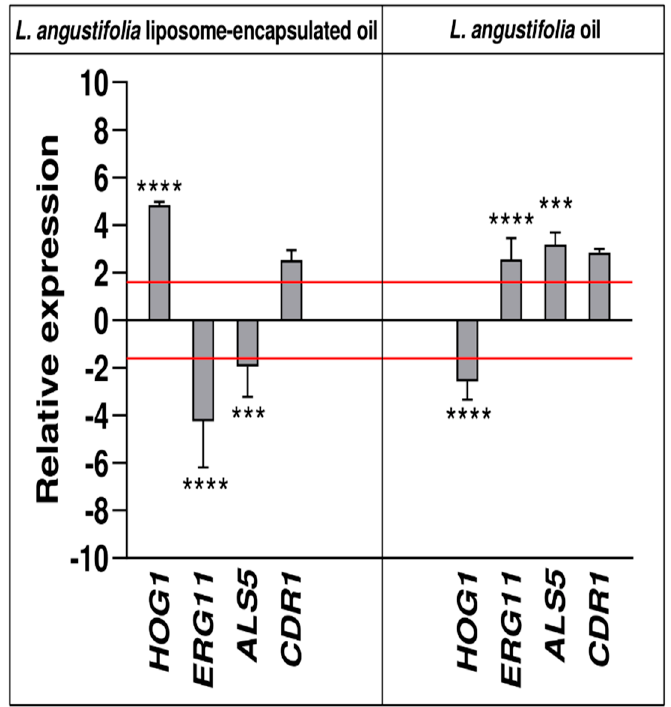
Figure 8. Real-time qPCR at 48 h of treatment. Histograms show the differences in the expression levels of three virulence genes, one adhesion gene, one gene involved in hyphal formation. Fold differences greater than ± 1.5 (see red dotted horizontal guidelines at values of +1.5 and − 1.5) were considered significant (see Table S2 for the values). A Brown–Forsythe test Sisak’s test (**** p < 0.0001; *** p < 0.001).